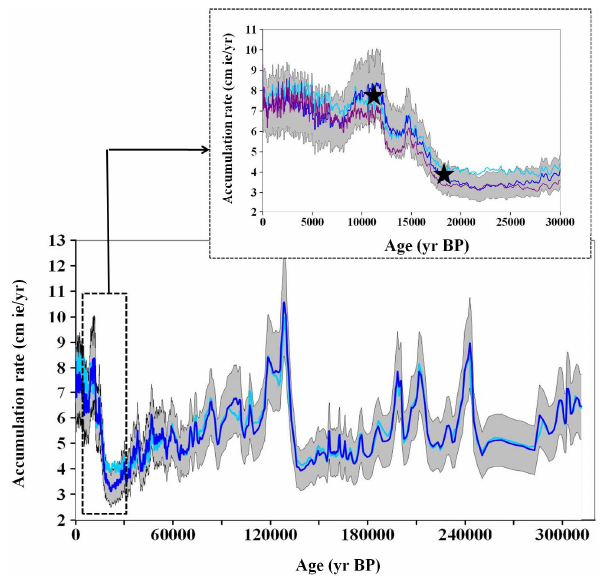
Fig. 7: Accumulation rate history deduced from the water isotopic profile corrected from elevation changes (light blue line) and after adjustment by the inverse method (dark blue line). The grey area represents the error interval for an accumulation rate varying by ± 20 % around the value deduced from the inverse method. Inside frame: zoom over the last deglaciation period. We add the 10 Be constraints for Holocene and LGM periods (stars); it is set to match the average Early Holocene accumulation rate deduced from the inverse and direct reconstructions, and then shown with the ratio calculated between Holocene and LGM periods as explain in section 5.2.1.2. We also plot the accumulation rate calculated by the traditional isotopic equation for a value of β =0.0198 (purple line), after having corrected the water isotopic data from elevation changes.